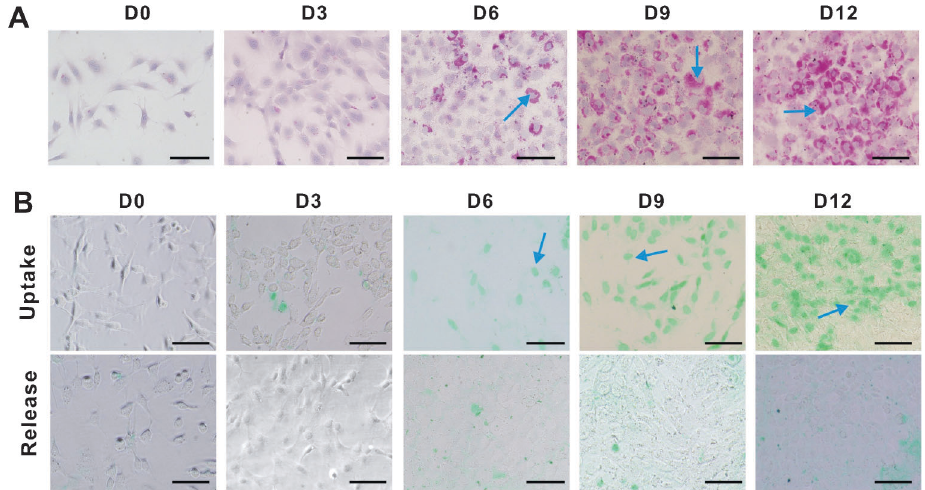
Figure 4. Hepatic functions of induced hepatic progenitor cells (HPCs). Hepatic functions of induced HPCs were analyzed at D0, D3, D6, D9, and D12 following treatment with 2% HS++0.1 m M Dex++10 ng/mL HGF++20 ng/mL FGF4. A , PAS staining of the glycogen storage and accumulation function in the induced HP14.5 cells. The red granular staining in cytoplasm is indicated with arrows. B , ICG uptake and release assay for the transport and metabolism function of the induced HPCs. Green-stained cells are indicated with arrows. The staining was performed in at least three independent experiments, and representative results are shown. See Figure 1 for explanation of abbreviations. Scale bar=200 m